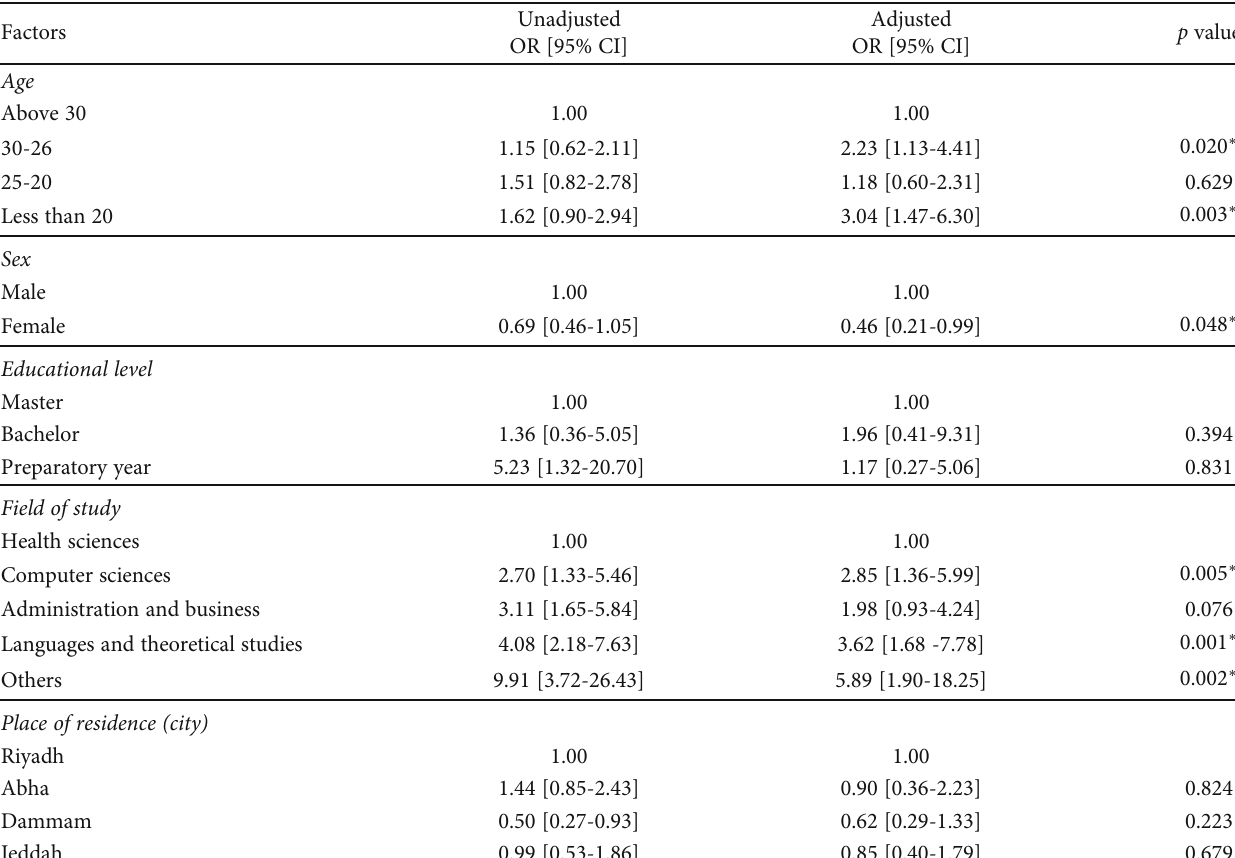
Table 3: Results of logistic regression for unadjusted and adjusted odds ratios for association between student ’ s poor + knowledge of foodborne pathogens and their sociodemographic characteristics ( N = 399